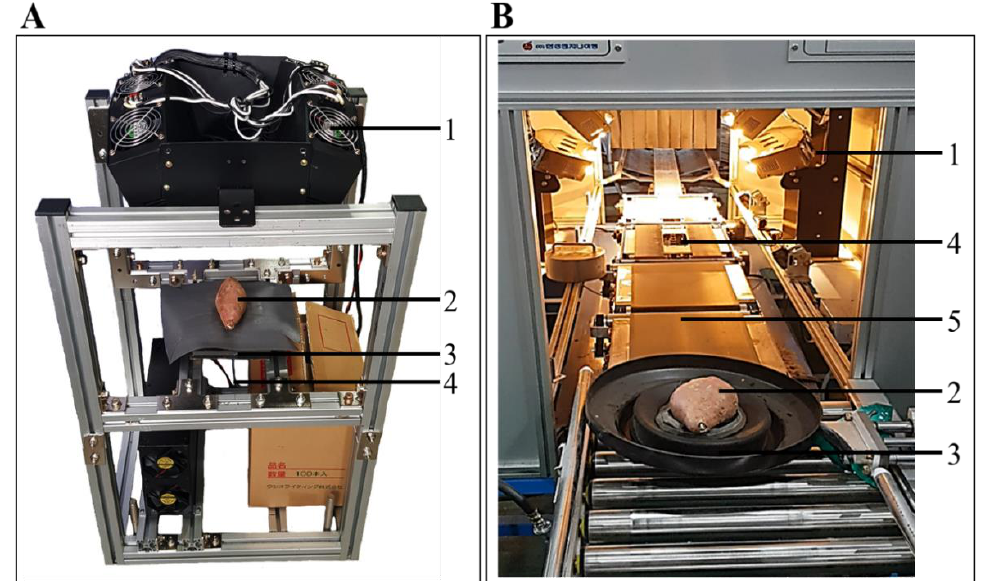
Figure 1. Setting of ( A ) laboratory experimental device and ( B ) industrial device for measuring NIR spectra of sweet potato. 1, NIR light source; 2, sweet potato (sample); 3, sample holder; 4, detector; and 5, conveyor belt.